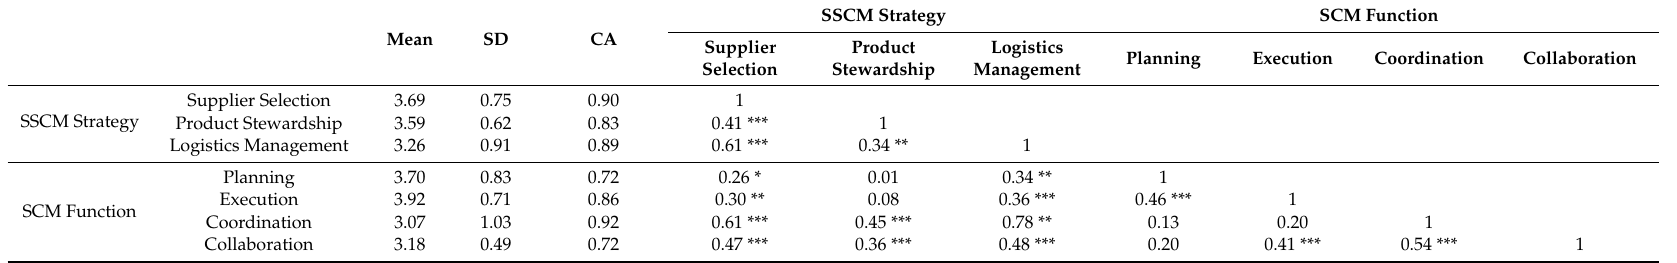
Table 11. Results of correlation